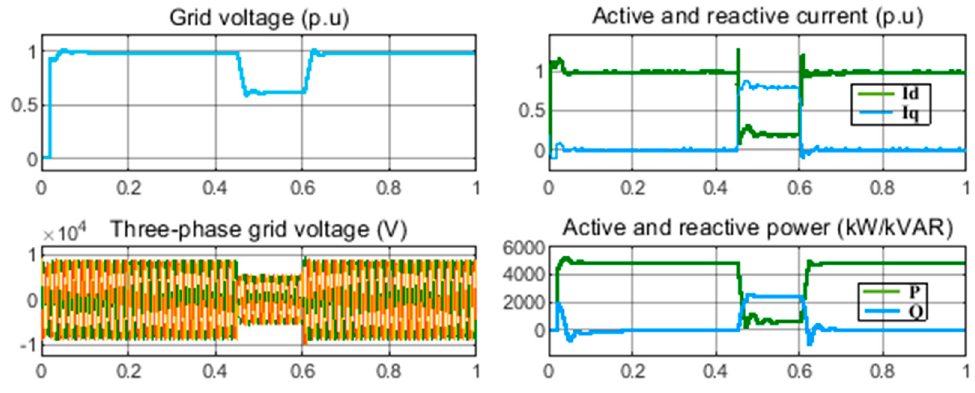
Figure 11. Simulation results of an LVRT control strategy with symmetrical 3-phase fault when the voltage dropped by 40% from its nominal voltage (voltage sag 60%) for 150 ms.